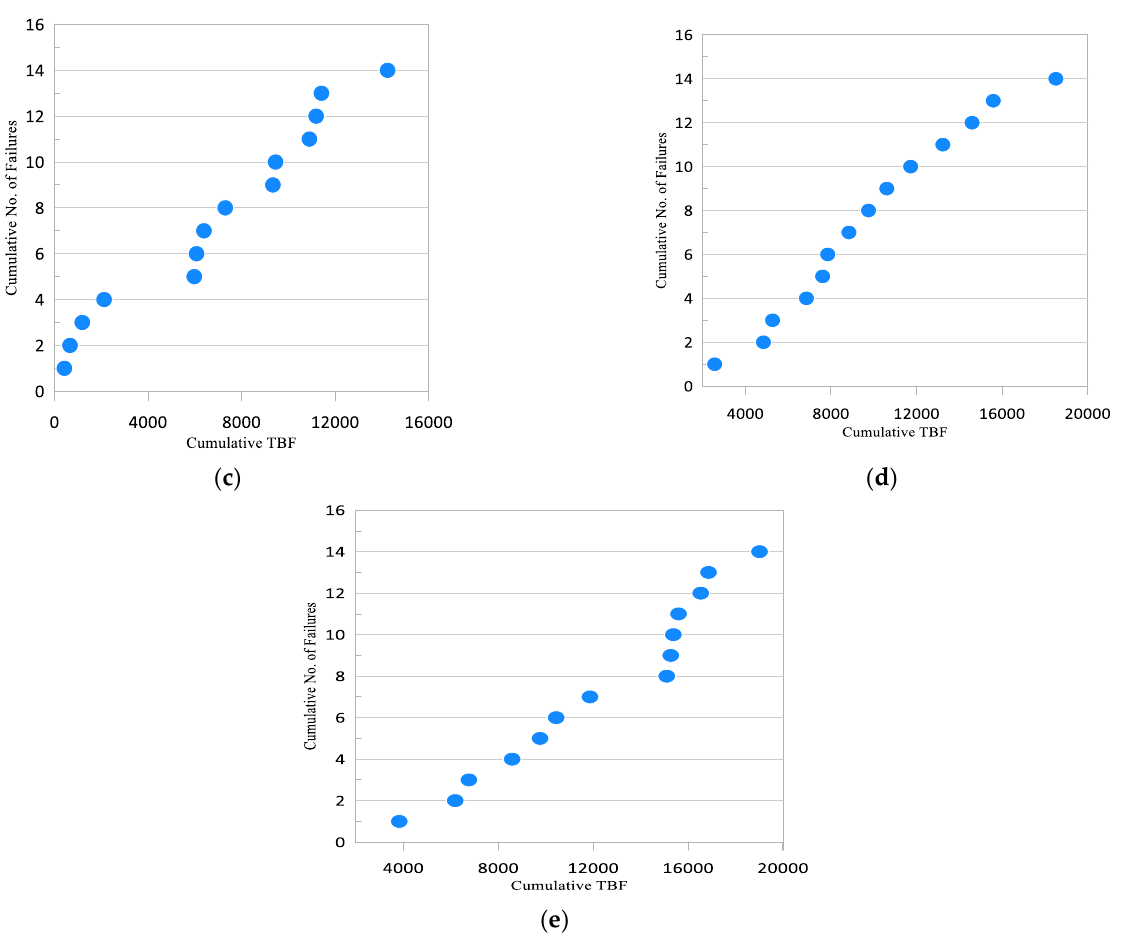
Figure 4. ( a ). Trend test of TBF data for air supply subsystem; ( b ). Trend test of TBF data for self-stating subsystem; ( c ). Trend test of TBF data for fuel supply subsystem; ( d ). Trend test of TBF data for lubrication subsystem and ( e ). Trend test of TBF data for cooling subsystem.